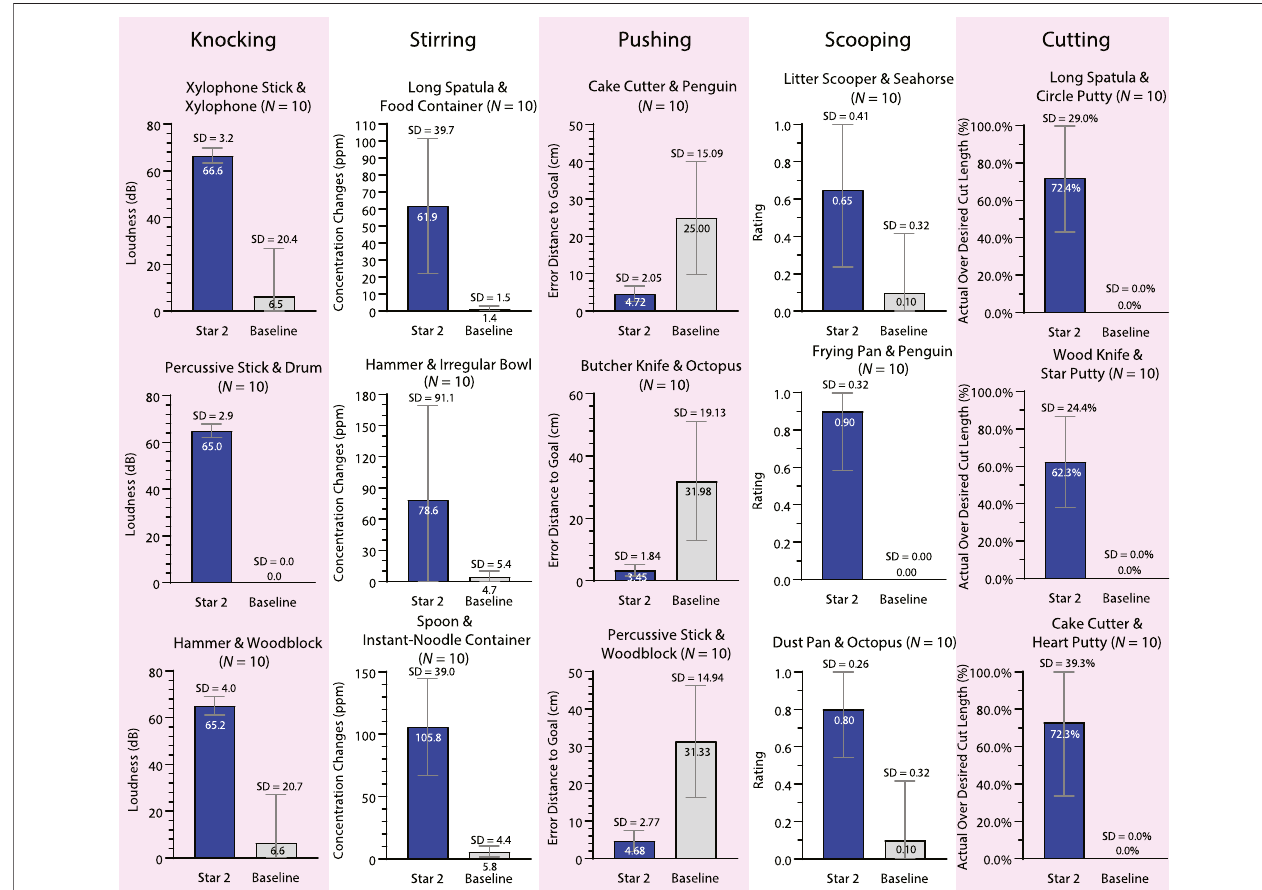
FIGURE 10 | Results of tool substitution and manipulandum substitution (Star 2). The bar graphs show the results of using the substitute objects to perform knocking, stirring, pushing, scooping, and cutting. The bars compare Star 2 ’ s (blue) performance against the baseline (gray).